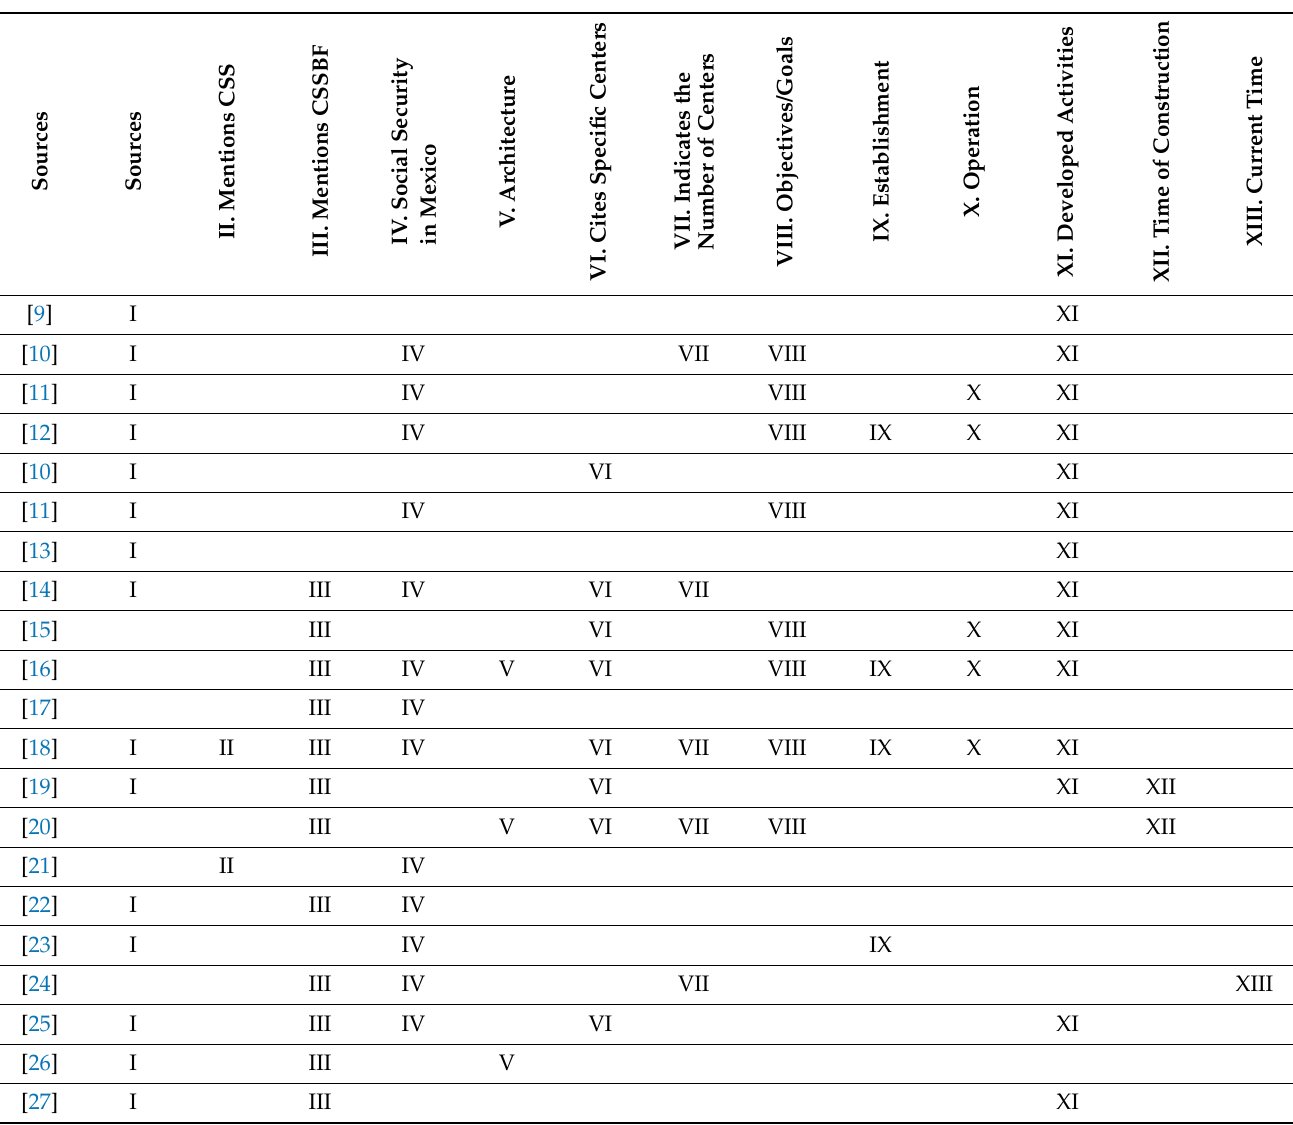
Table 1. Organizational table of the main bibliographic sources located around Casas de la Asegurada. Sources are classified according to the following topics: (I) The source refers to the object of study as Casa de la Asegurada, (II) The source refers to the object of study as Centro de Seguridad y Salud, (III) The source refers to the object of study as Centro de Seguridad Social y Bienestar Familiar, (IV) The source describes how Seguridad Social in Mexico works, (V) The source describes architectural aspects of the object of study, (VI) The source mentions or describes specific examples of the Casas de la Asegurada, (VII) The source specifies the number of Casas de la Asegurada existing in Mexico City, or Mexico, at the time, (VIII) The source lists and/or describes the objectives of the Casas de la Asegurada, (IX) The source describes the characteristics required for the establishment of a Casa de la Asegurada, (X) The source describes how the Casas de la Asegurada operate, (XI) The source lists and/or describe the activities developed in the Casas de la Asegurada, (XII) The source focuses on the building moment of a specific Casa de la Asegurada, (XIII) The source provides current data regarding the Casas de la Asegurada.